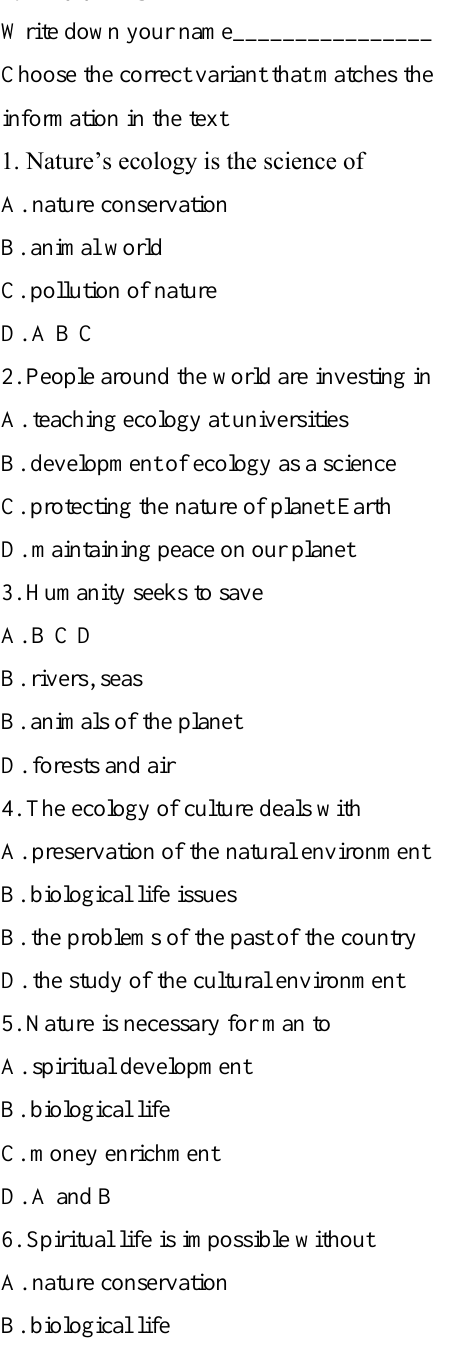
Choose the correct variant that matches the information in the